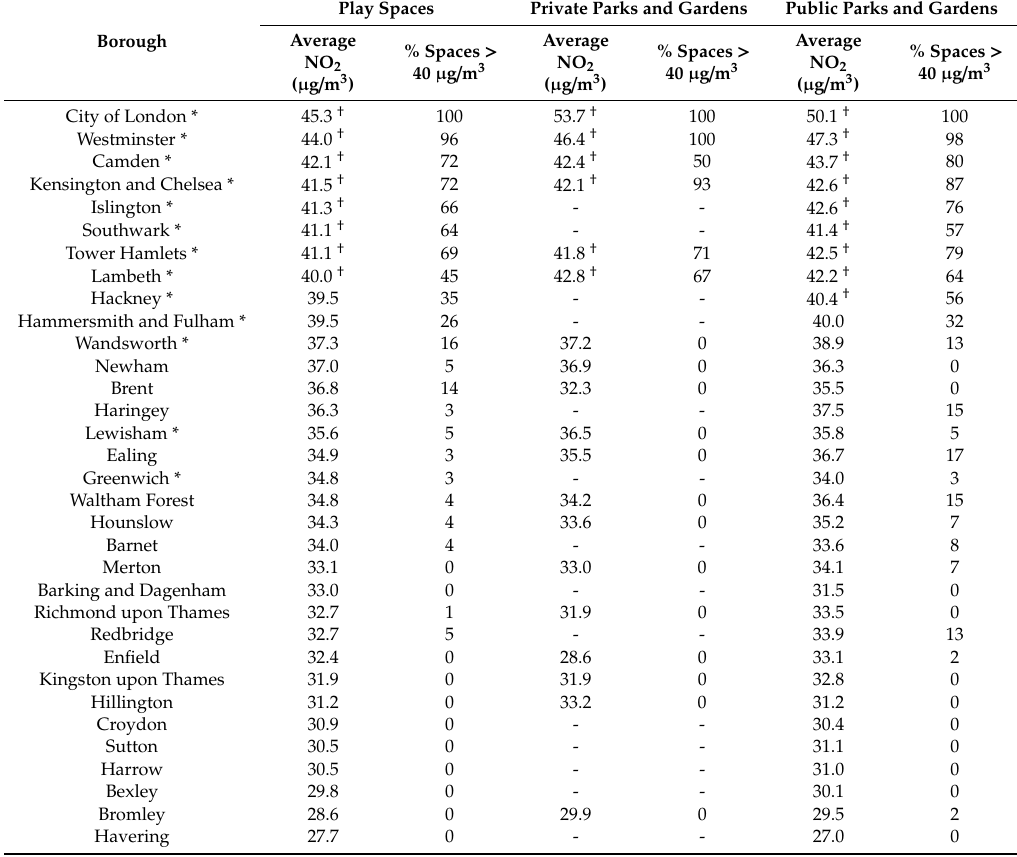
Figure 3. 2016 annual average of NO 2 concentrations across open spaces in Greater London, areas above the 40 µg/m 3 legal limit shown in red [Contains OS Open Data © Crown copyright and database right 2019; OS licenced data © Crown copyright and database rights 2019 Ordnance Survey (100025252) and data provided by Greenspace Information for Greater London CIC, with permission to publish for illustrative purposes only, 2019; public sector information licensed under the Open Government Licence v2.0]. Table 2. Annual average NO 2 concentrations in play spaces, private parks and gardens and public parks and gardens by London Boroughs (ranked by average NO 2 levels in play spaces), including the percentage of spaces above the legal limit of 40 µg/m 3 .